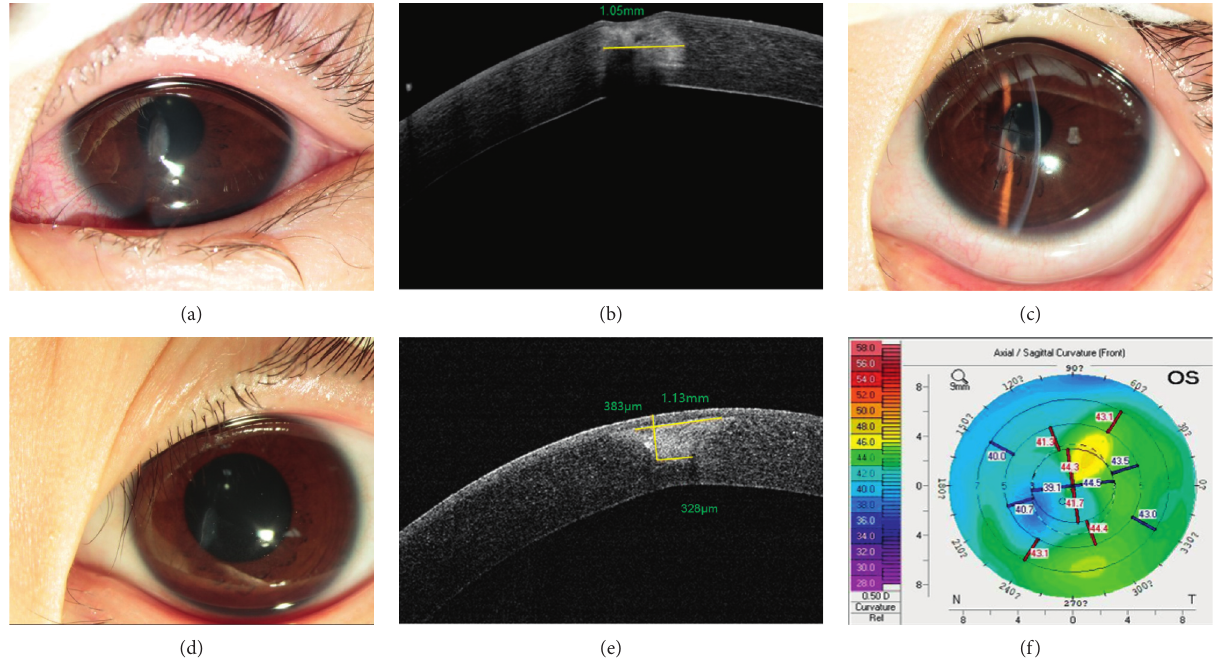
Figure 5: Lamellar corneal patching with an irregular wedge-shaped graft for pencil pricking. (a) The lamellar laceration is in the central cornea with stromal edema, and the UCVA is 1.0 logMAR. (b) AS-OCT shows inflammatory infiltration in a range of 1.05mm. (c) Photograph at 1 week after surgery. (d–f) Examination at 4 years after surgery. (d) The graft opacity is decreased, and the UCVA is 0.22 logMAR. (e) AS-OCTshows that the width of the anterior surface of the patch is 1.13mm, and that of the posterior surface is 328 μ m. The anteroposterior diameter of the patch is 383 μ m. (f) The curvature of the front cornea is